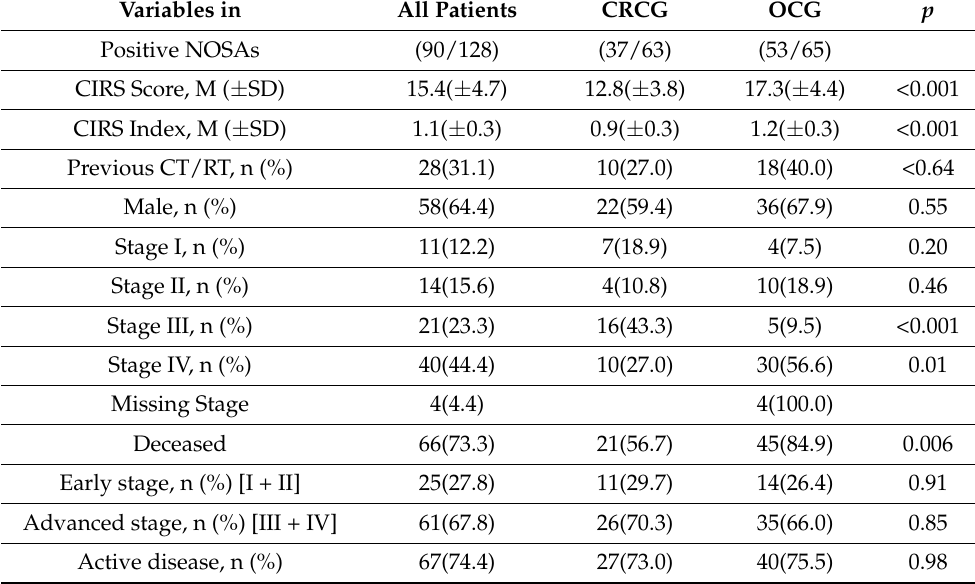
Table 3. Analysis of specific characteristics of the patients in relation to non-organ specific autoan- tibody (NOSA) positivity, and in the two groups (CRCG, colorectal cancer group, and OCG, other cancer